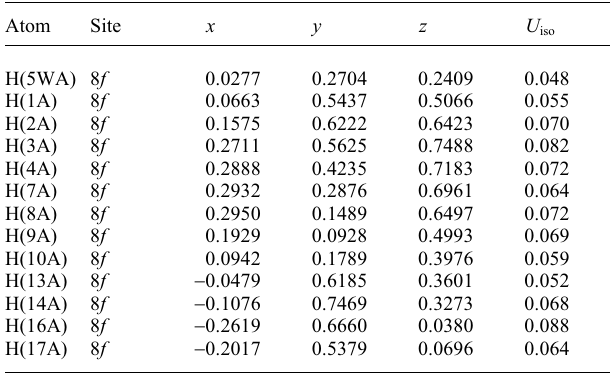
Table 2. Atomic coordinates and displacement parameters (in Å 2 )